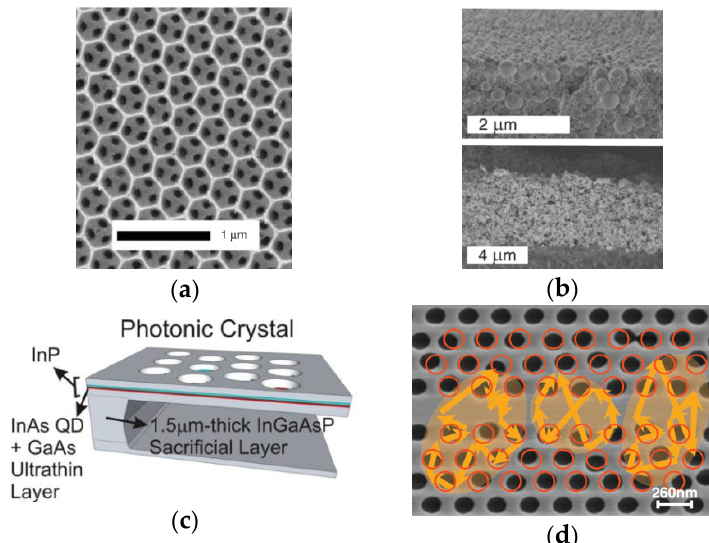
Figure 4. Various types of dielectric environment to control spontaneous emission. ( a ) CdSe QDs embedded in 3D inverse opal photonic crystals; ( b ) Fluorescent polystyrene nanospheres embedded in 3D random photonic media of polystyrene (top) and ZnO (bottom); ( c ) InAs QDs and single ultrathin GaAs layer grown between two 110 nm-thick InP photonic crystal layers; ( d ) 2D photonic crystal waveguide with 6% engineered disorder; (a,c) are ordered arrays; (b,d) are disordered arrays. Figures reproduced from ( a ) Lodahl, P., et al. Nature 2004 , 430 , 654. Copyright 2004 by Springer Nature; ( b ) Birowosuto, M.D., et al. Phys. Rev. Lett. 2010 , 105 , 013904. Copyright 2010 by American Physical Society; ( c ) Birowosuto, M.D., et al. Sci. Rep. 2012 , 2 , 321. Copyright 2012 by Springer Nature ( d ) Sapienza, L., et al. Science 2010 , 327 , 1352. Copyright 2010 by American Association for the Advancement of